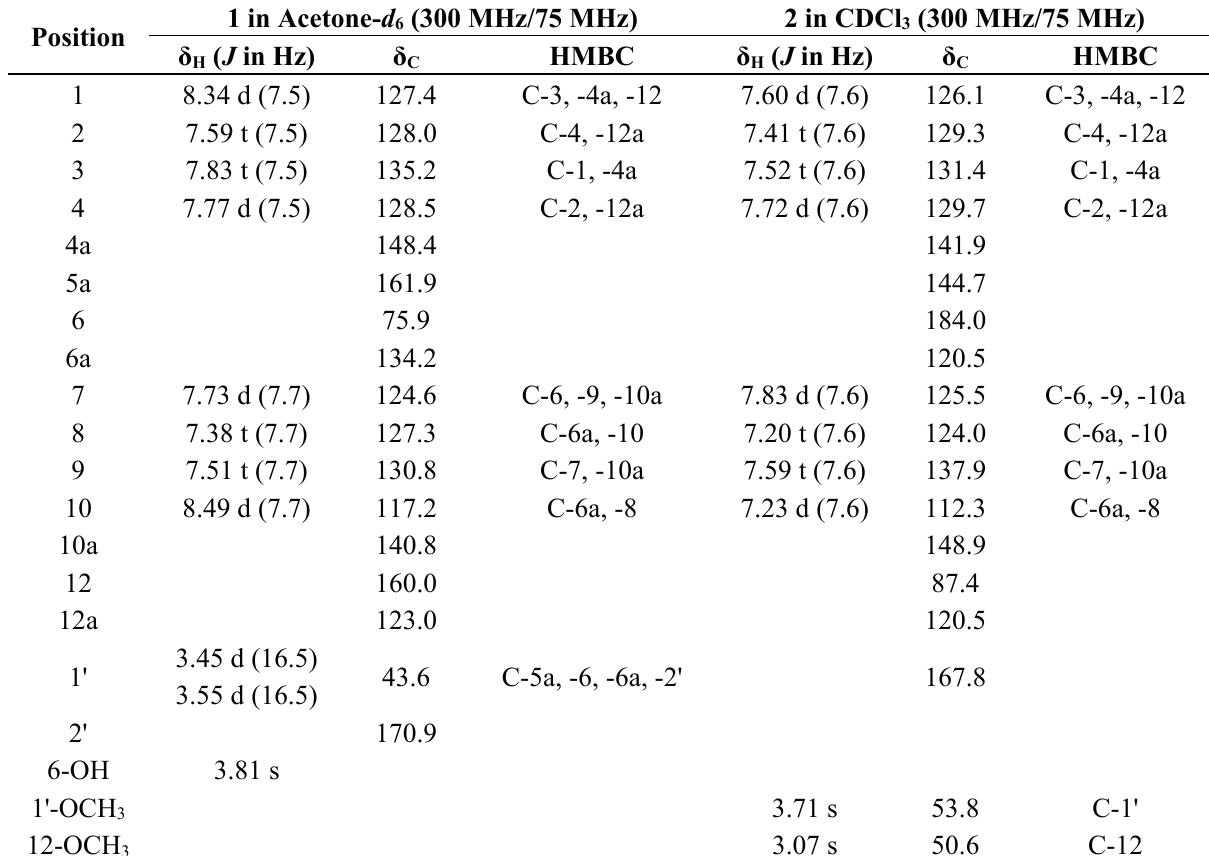
Table 1. 1 H and 13 C NMR Spectroscopic Data and HMBC Correlations for Cephalanthrins 1 and 2